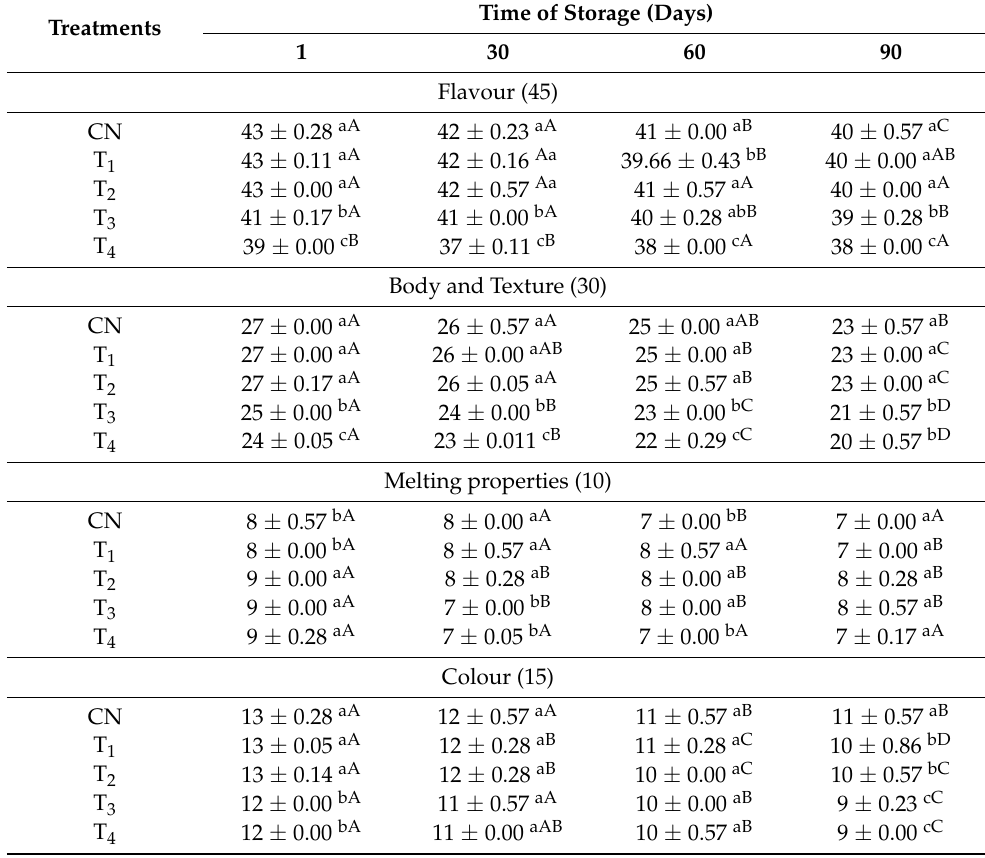
Table 7. Sensory evaluation of frozen yoghurt affected by using JATP.